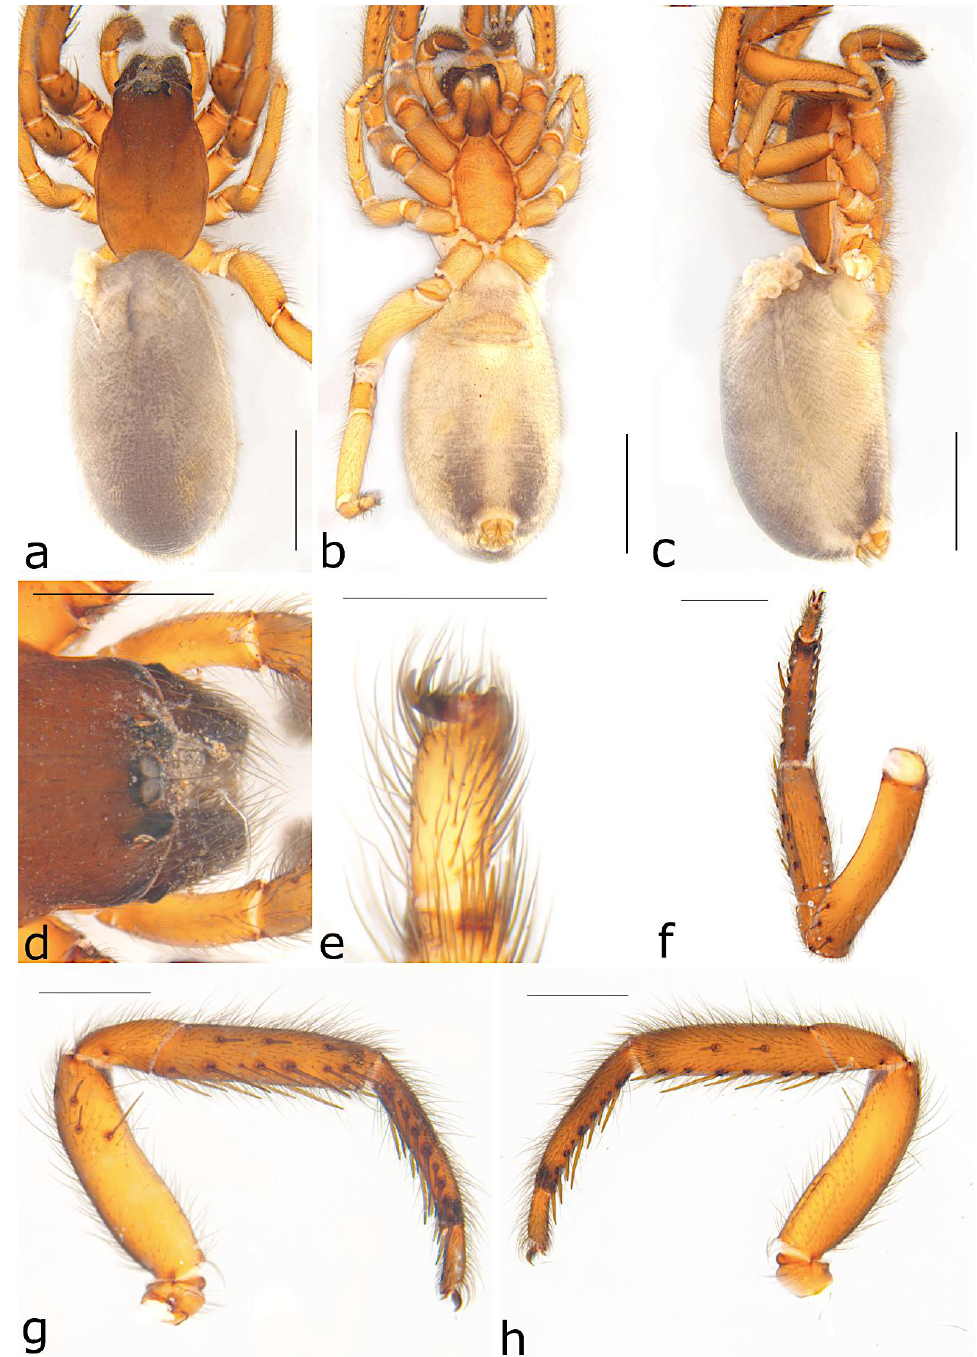
Figure 75. Ariadna woinarskii sp. nov. ♀ paratype (SAMA NN31201) from Kangaroo Island (SA): ( a ) habitus, dorsal view; ( b ) same, ventral view; ( c ) same, lateral view; ( d ) eyes, dorsal view; ( e ) left metatarsus IV, preening comb, retrolateral view; ( f ) left leg I, ventral view; ( g ) same, prolateral view; ( h ) same, retrolateral view. Scale bars ( a – d , f – h ) = 1 mm and ( e ) = 0.5 mm.